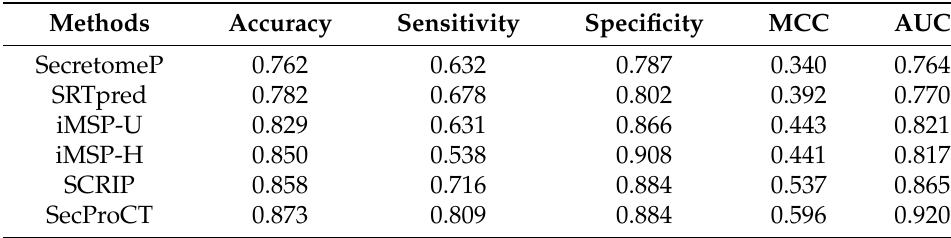
Table 6. Performance of SecProCT and other methods on the iMSP test